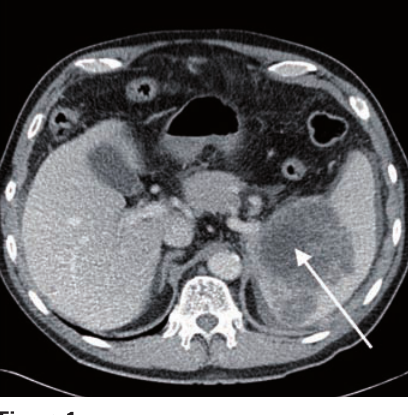
Figure 1 CT scan showing a heterogeneous splenic cyst (arrow) and a small amount of perisplenic liquid.